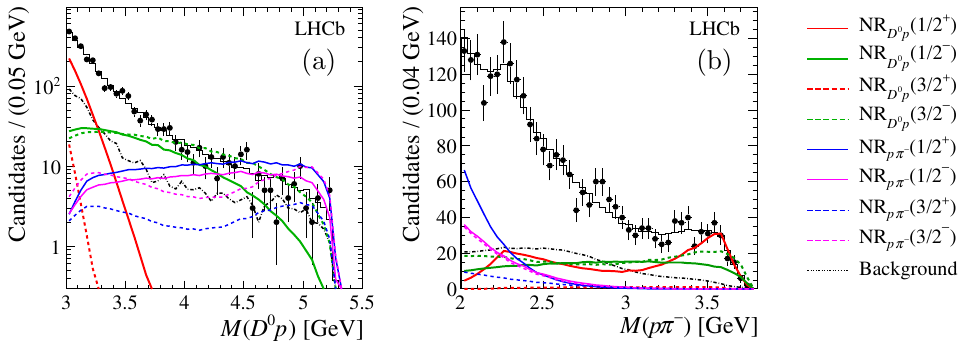
Figure 6 . Fit results for the (cid:3) 0 ! D 0 p(cid:25) (cid:0) amplitude in the nonresonant region (region 1) (a) b M ( D 0 p ) projection and (b) M ( p(cid:25) (cid:0) ) projection. The points with error bars are data, the black histogram is the (cid:12)t result, and coloured curves show the components of the (cid:12)t model taking into account the e(cid:14)ciency. The dash-dotted line represents the background. Due to interference e(cid:11)ects the total is not necessarily equal to the sum of the components.